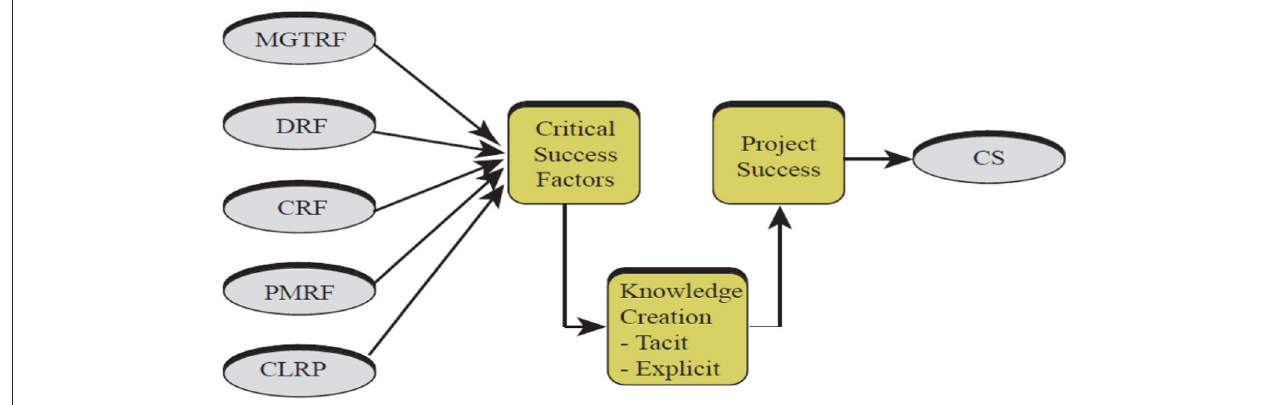
FIGURE 1 | Conceptual framework. Source: Author’s